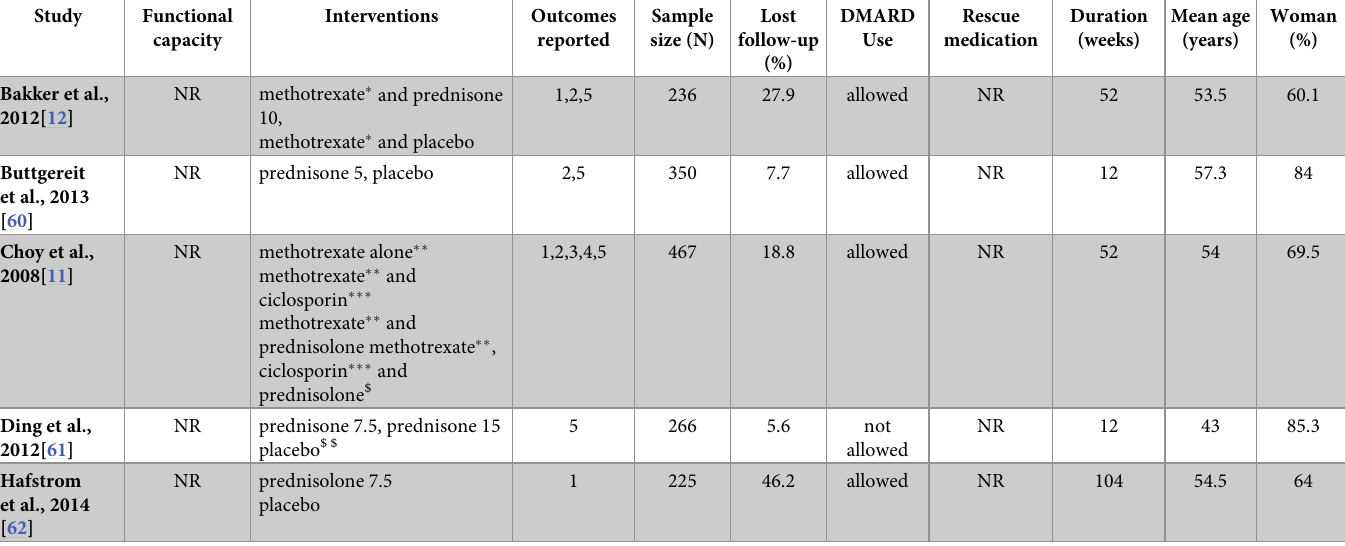
Table 3. Characteristics of the studies on corticoids anti-inflammatories for rheumatoid arthritis (n = 5).